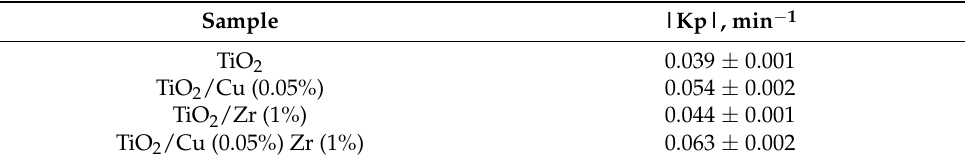
Figure 10. Decay profiles for first-order photocatalytic reactions during simulated solar light irradiation of RB19 aqueous solutions in presence of unmodified TiO 2 and Cu- and/or Zr-modified TiO 2 materials. Table 3. Photocatalytic reaction rate constants for different TiO 2